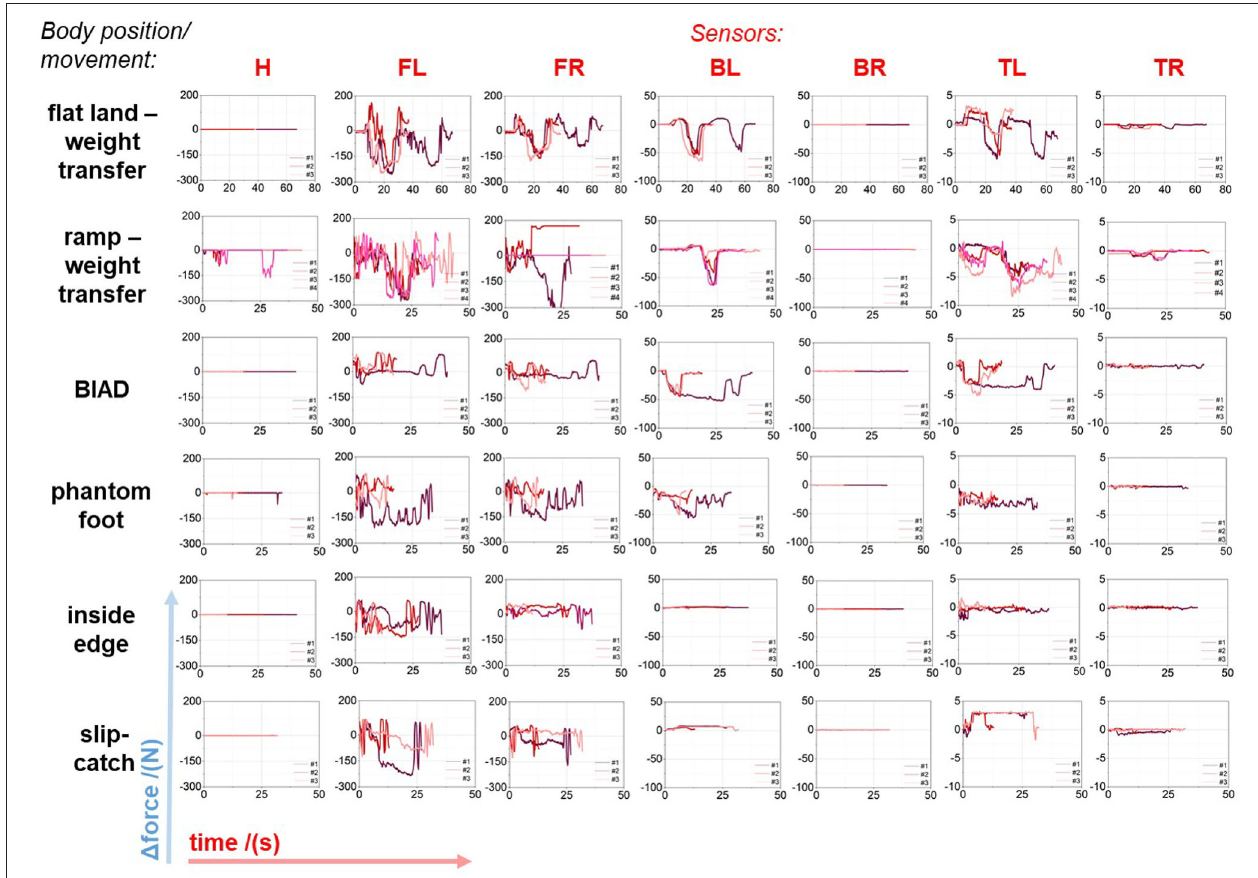
FIGURE 5 | Referenced force over test time diagrams of all sensors. The force is referenced prior each measurement by a standardized procedure. Multiple measurement cycles are illustrated. Six skiing situations were simulated under laboratory conditions (body position and movement). BIAD, boot induced anterior drawer; inside edge …VER; slip-catch …hyperextension of the knee